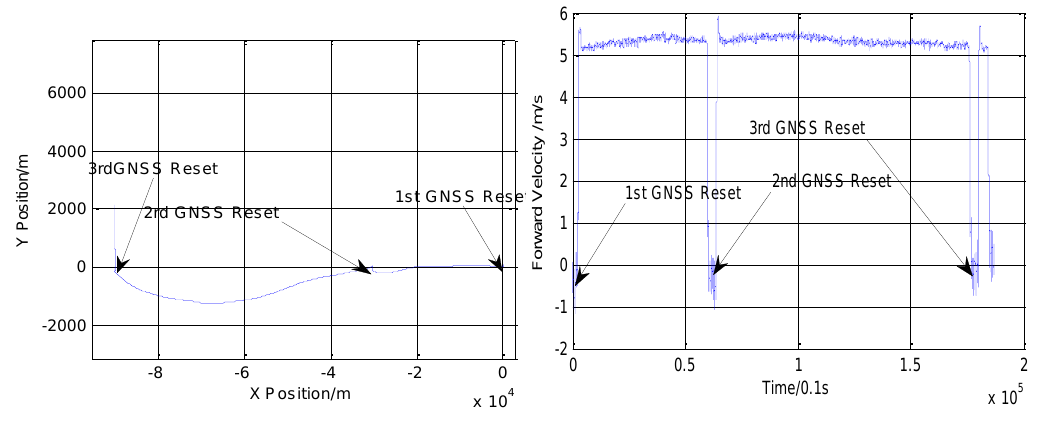
Figure 8. The trajectory and forward velocity of the AUV in Experiment